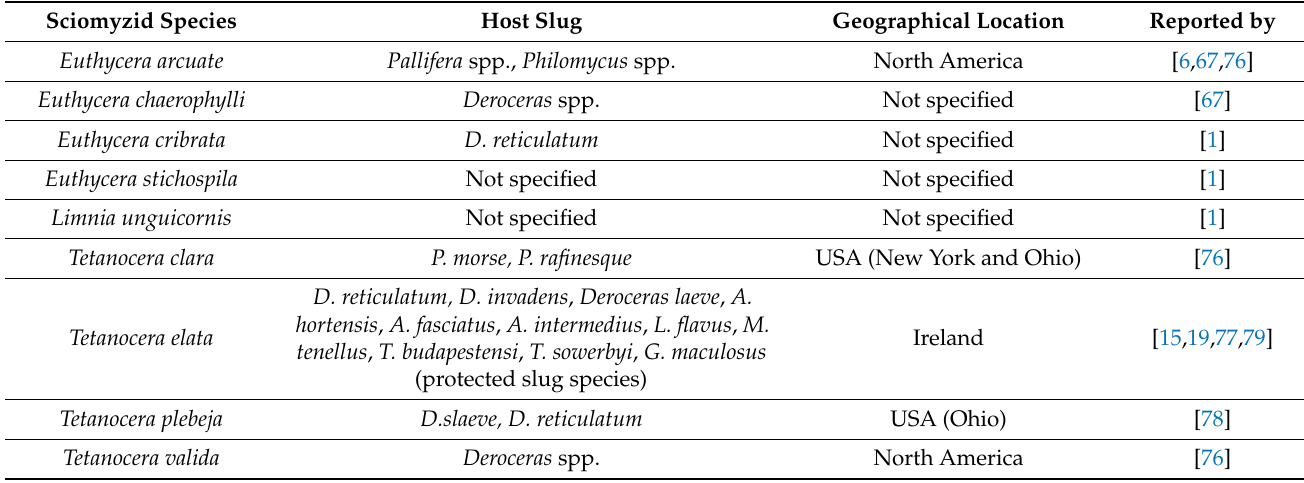
Table 2. List of slug-controlling sciomyzid